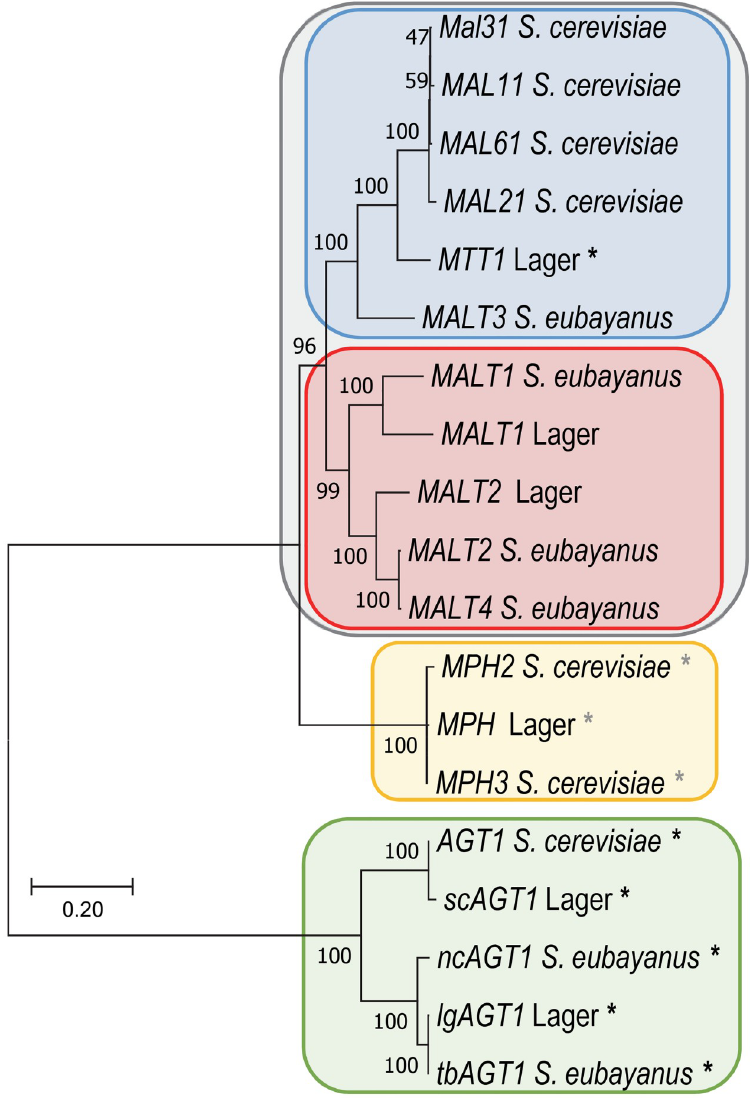
Fig 2. Phylogeny of Saccharomyces MALT genes. ML phylogenetic tree of MALT genes described in S . cerevisiae , S . eubayanus , and lager-brewing hybrids. The scale bar equals the number of nucleotide substitutions per site. Black “ � ” indicate genes characterized as encoding proteins capable of transporting maltotriose. Gray “ � ” indicates genes encoding transporters whose ability to transport maltotriose is ambiguous.